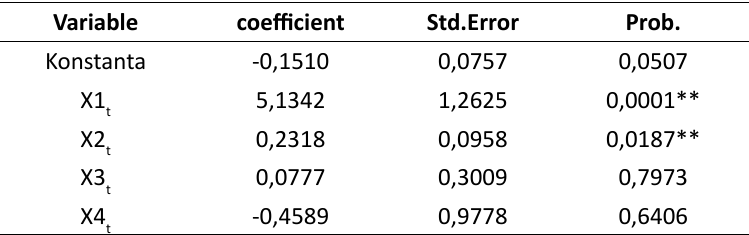
Table 6: Long Term Estimation Results Variable Std.Error